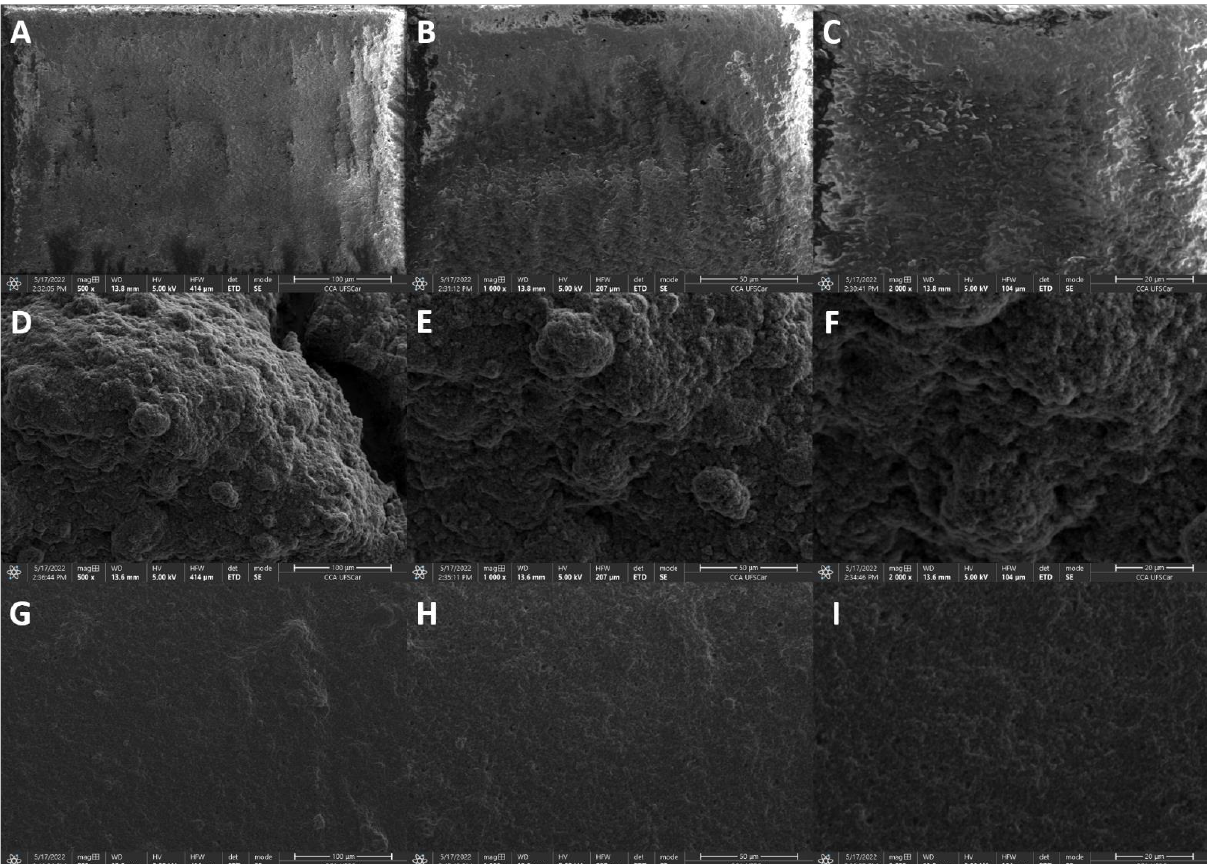
Figure 4 . SEM images of the 66.67% CB/CA ink without CB ( A – C ), without CA ( D – F ) and the com- plete ink ( G – I ) at ( A , D , G ) 500×, ( B , E , H ) 1000×, and ( C , F , I ) 2000×